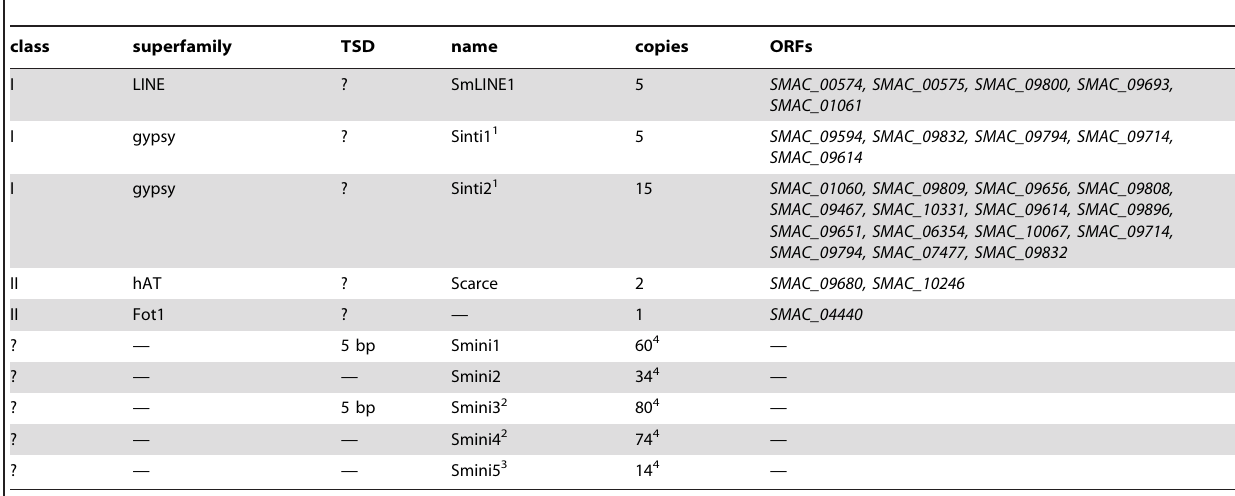
Table 4. Repeated sequences and transposons in the S. macrospora genome.